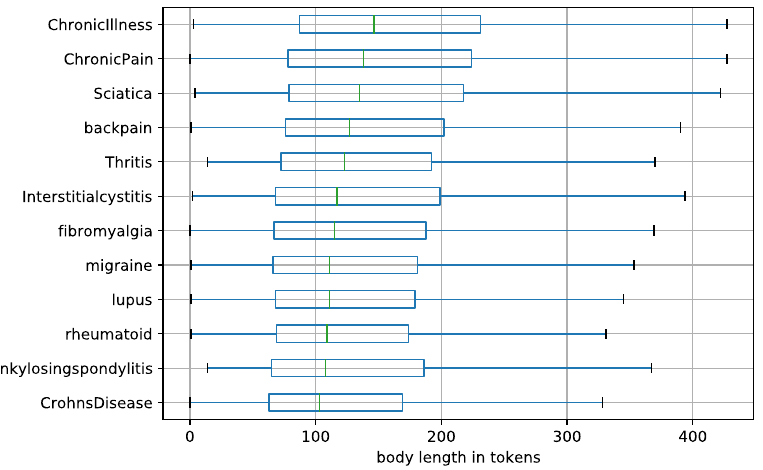
Figure A4. Distribution of the body length in tokens per submission (outliers are omitted).